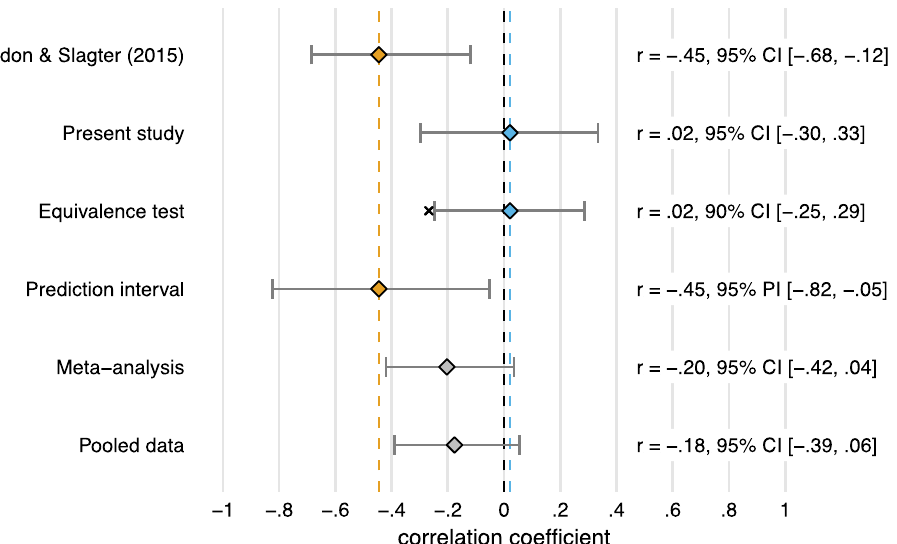
Fig 6. Summary of all the replication analyses (with exception of the replication bayes factor). The first two rows show the partial correlation (attempting to adjust for Session order) between the AB magnitude change scores (tDCS— baseline) in the anodal and cathodal sessions, for study 1 [20] (in yellow) and the present study (in blue). The first is significantly negative, the second is slightly positive and not significant, because its 95% confidence interval (CI) overlaps with zero. The third row shows the 90% CI around the correlation in the present study. Because this interval does not overlap with the “small telescopes” effect size, (indicated by the x: − r 33% = -.27), this correlation is significantly smaller. The fourth row shows the 95% prediction interval (PI) around the correlation in [20]. Because this interval does not overlap with the correlation in the present study, both correlations are not consistent. The final two rows show the overall effect when the two correlations are meta-analyzed, and when one correlation is computed over the pooled data from both studies. Neither are significant (95% CI overlaps with zero). Thus, our replication analyses all suggest that we failed to replicate London & Slagter [20], and when the results are examined in combination, no evidence in support of a negative relationship between the AB magnitude change scores (tDCS—baseline) in the anodal and cathodal sessions is